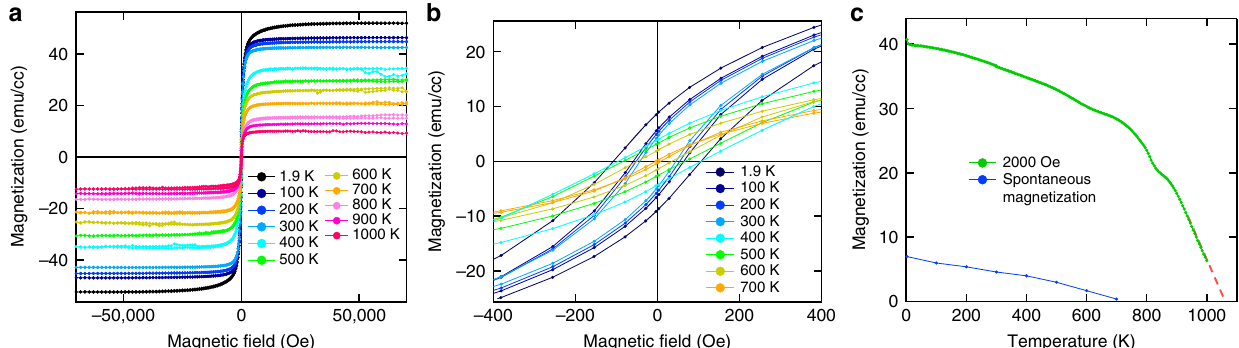
Fig. 2 Magnetic properties of a Sr 3 OsO 6 fi lm. a In-plane M – H curves at 1.9 up to 1000 K for a Sr 3 OsO 6 fi lm grown on (001) SrTiO 3 . Here, H was applied to the [100] direction. b Close-up near the zero magnetic fi eld in a . c M – T curve with H = 2000 Oe applied to the [100] direction for a Sr 3 OsO 6 fi lm grown on (001) SrTiO 3 . Spontaneous magnetization deduced from Fig. 2b as a function of temperature is also shown NATURE COMMUNICATIONS| (2019) 10:535